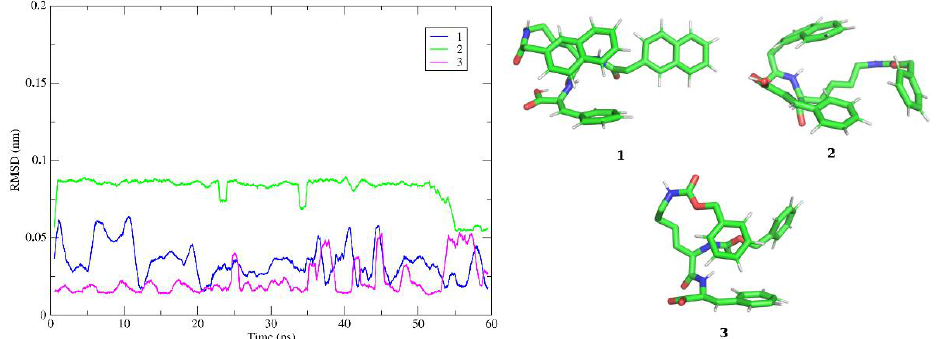
Figure 13. Left: Root mean square deviation (RMSD) of peptides backbone using backbone fitting, along simulation time. Right: Most typical conformation obtained for peptides 1 – 3 from cluster analysis. Carbons are represented in green, nitrogen in blue, oxygen in red, and polar/aromatics hydrogens in white. Peptides in united-atom stick representation.